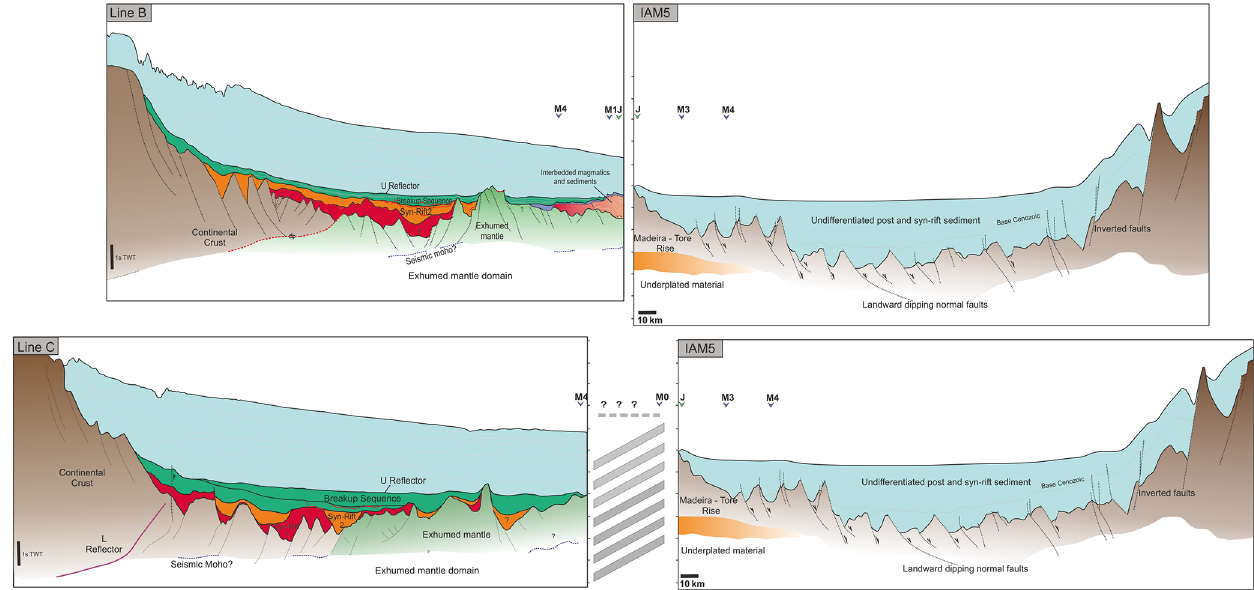
Figure 9. Comparison of “conjugate” seismic lines chosen on the basis of alternative rotation schemes for Barremian times. Conjugates according to (a) Greiner and Neugebauer (2013) and Seton et al. (2012) and (b) Srivastava et al. (1990). Conjugate comparisons are hung on 10s TWT. Key as in Figs.